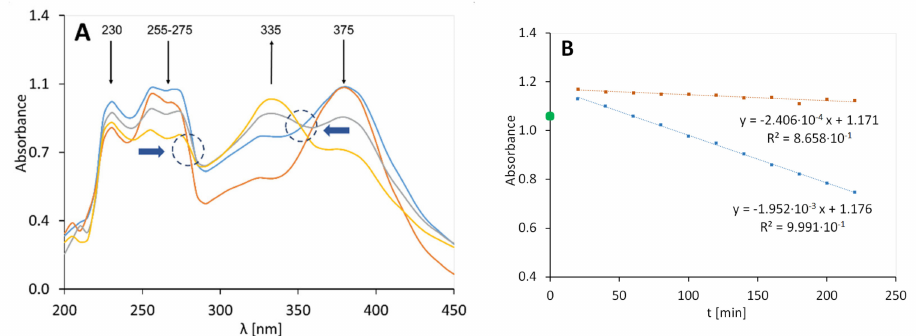
Figure 2. UV-Vis spectra of the polyacrylic acid (PAA) gel with quercetin and glycerol (preparation 2A), irradiated at 0 ( - ), 80 ( - ), 120 ( - ), and 200 ( - ) minutes ( A ). The graph on the right ( B ) shows the UV degradation of a gel containing PAA, quercetin, and glycerol (orange dots are used for the results of unexposed samples and blue dots are used for the result obtained for the irradiated samples).